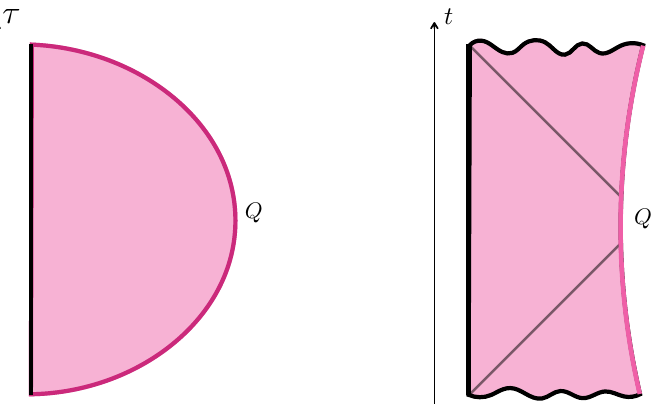
Figure 29 . The x = const . slice of the Euclidean setup and the Lorentzian counterpart of the small ∆ phase. The Lorentzian turns out to be a one-sided BTZ black hole with temperature 1 / (2 πa ) , and an end-of-the-world brane falling behind the